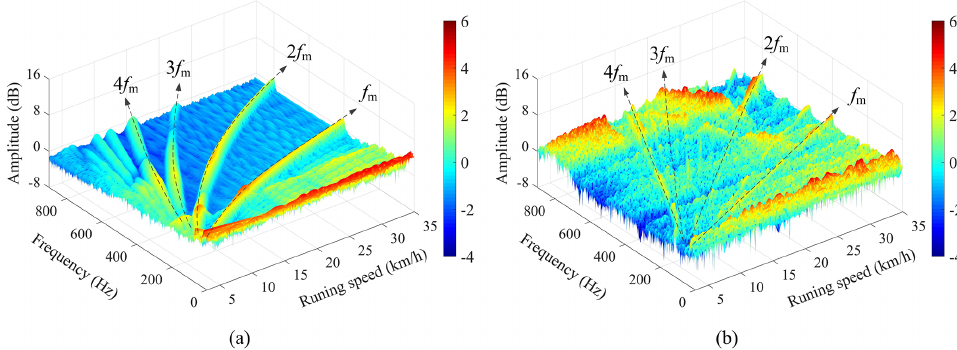
Figure 11. Time–frequency distribution of the bogie frame vibration responses: (a) simulated results, (b) field test